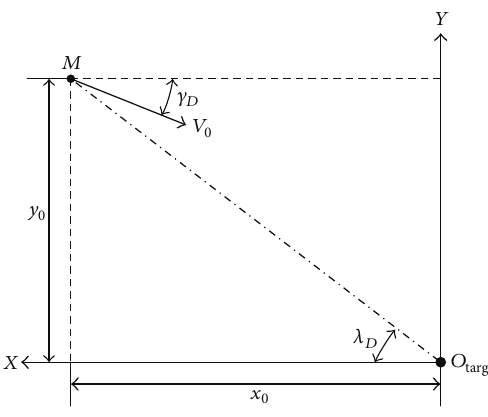
Figure 1: Coordinate system and